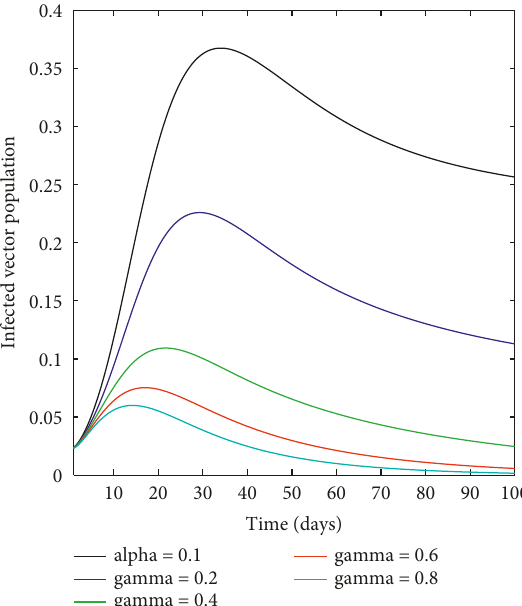
Figure 15: Increasing recovery rate with α � 0.2.